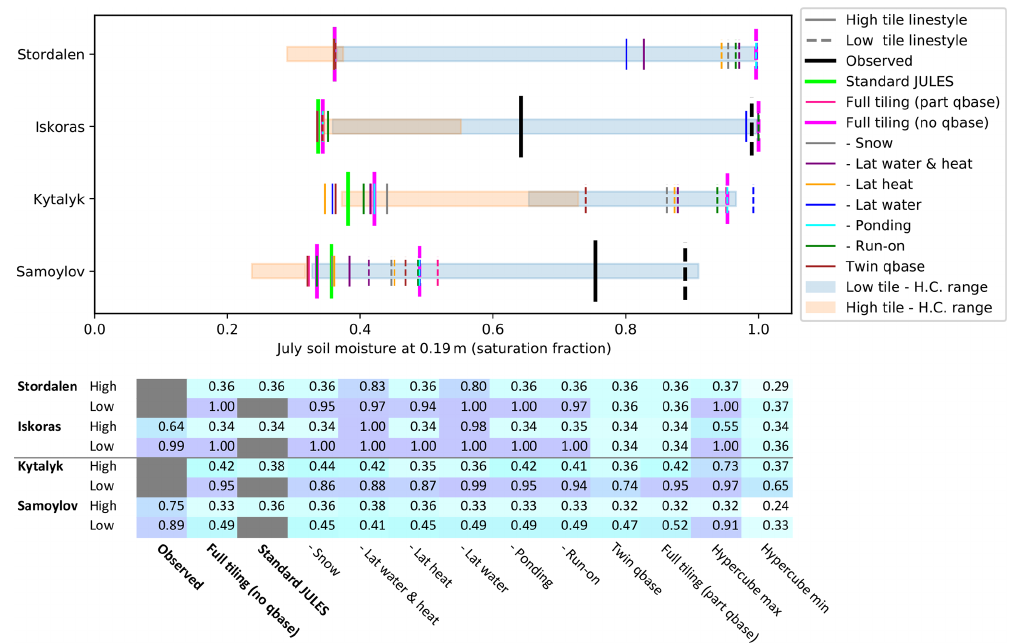
Figure 9. Average July soil moisture (2000–2016) at 0.19m for the subtractive process-switching runs, where model processes are switched off individually starting from the base configuration of full tiling (no qbase) (thick pink). Solid lines show the high tile, and dashed lines show the low tile. Observations are shown in black, standard JULES is shown in green. The range across the Latin hypercube sampling runs (H.C. range) are shown by the boxes. The depths of the observations are as follows: for Samoylov, the rim was at 0.22m and the centre was at 0.23m, and for Iškoras the palsa and mire were both at